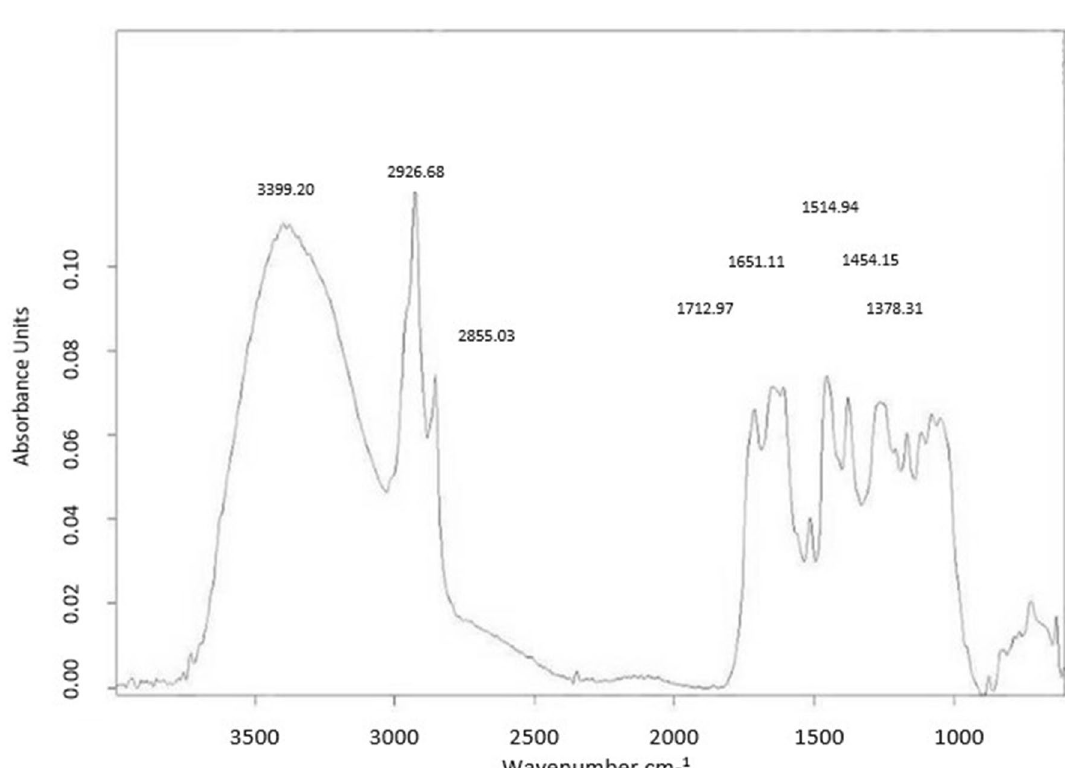
Figure 4. FT-IR analysis of Dodonaea viscosa flowers methanolic extract.